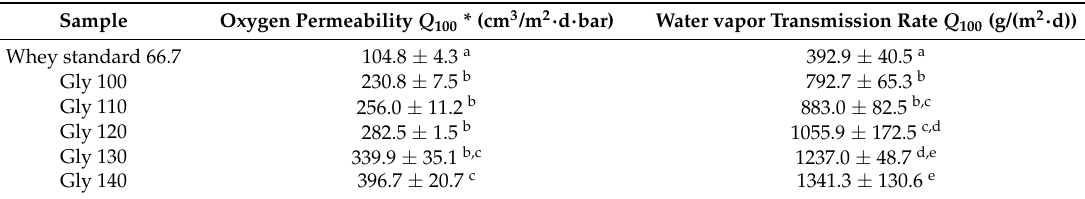
Table 4. Water vapor transmission rate and oxygen permeability of WPI standard and PPI-based films as a function of glycerol concentration ( w / w protein) normalized to 100- µ m film thickness. Significant differences are indicated by different superscript letters ( p <